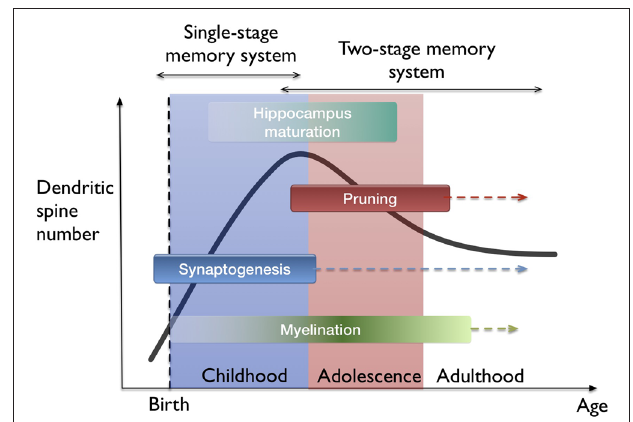
FIGURE 4 | Lifetime trajectory of dendritic spine density and the developmental stages in the brain. Significant changes occur as synaptogenesis saturates which also coincides with the hippocampus maturation. Arrows indicate continuing processes throughout lifetime, such as synaptogenesis, but at much lower rates. On top, the hypothesis of single-stage to two-stage memory system transition is